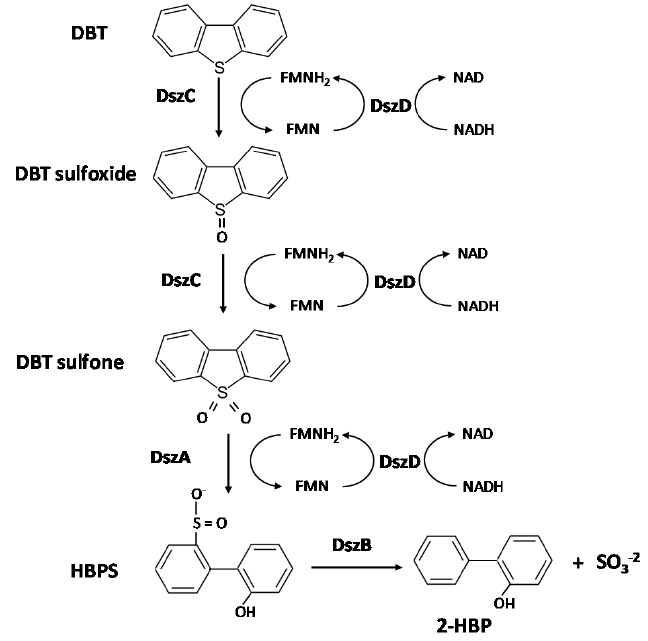
Figure 1. The 4S pathway for DBT desulfurization.